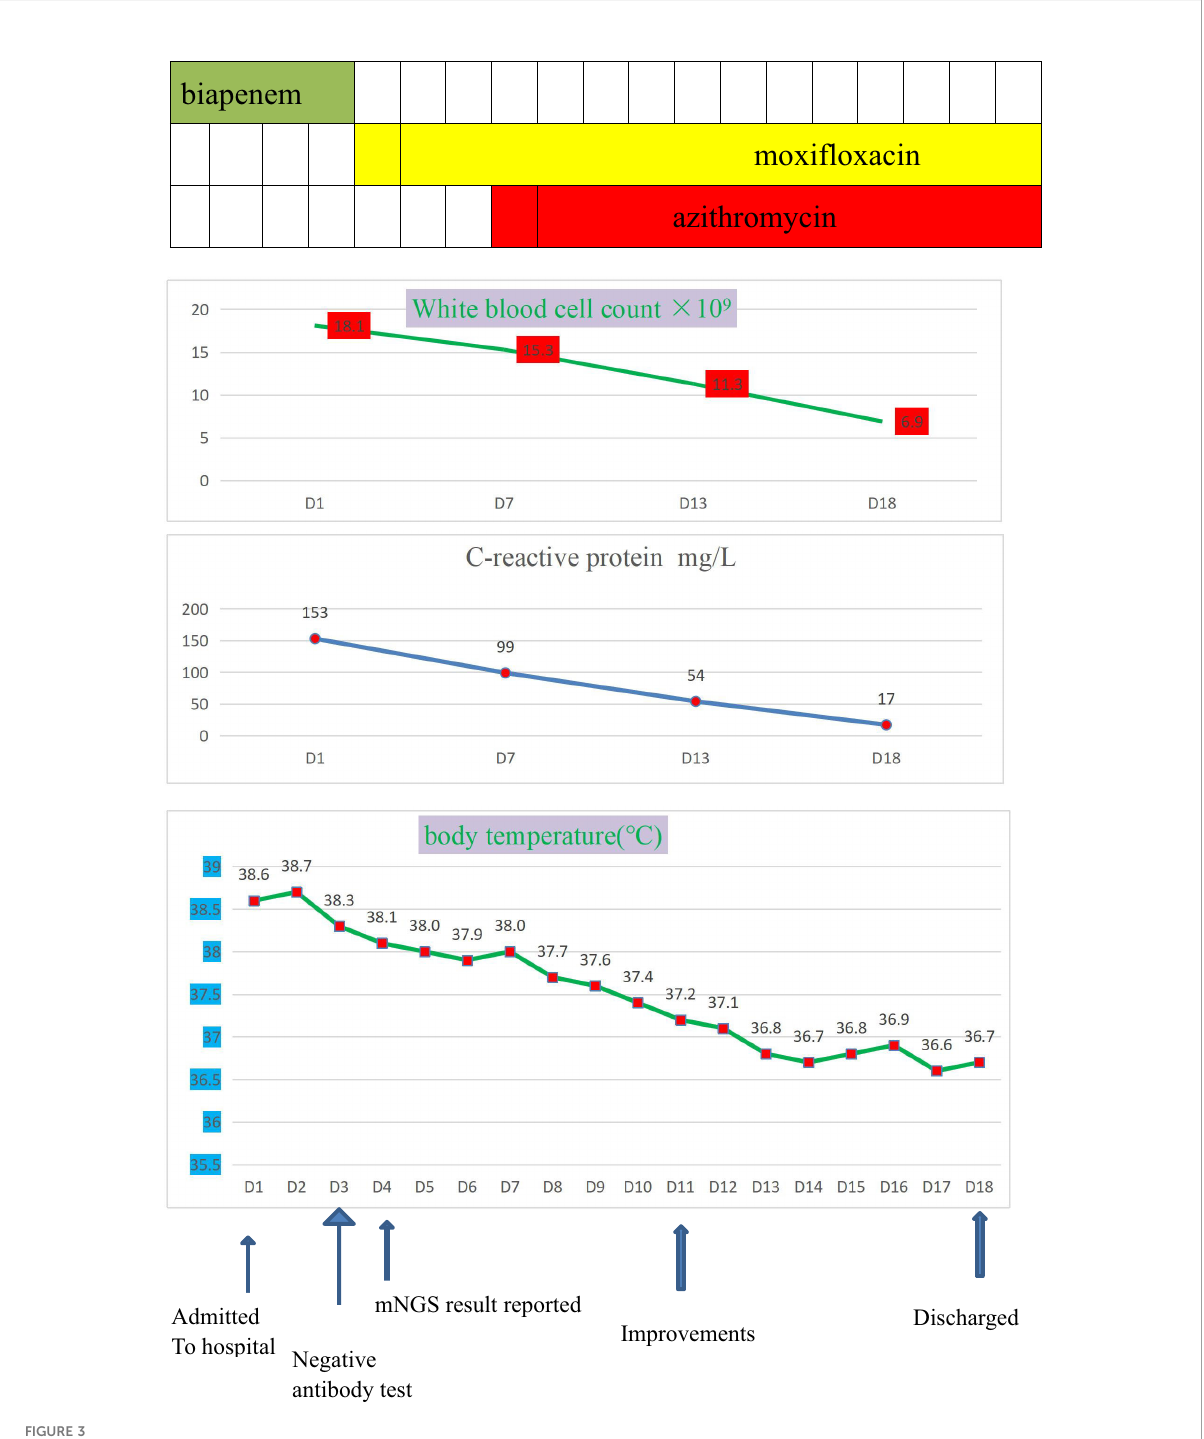
FIGURE 3 The clinical course of the patient with Legionella pneumophila infection.Drug therapies (top), blood indicators (middle), and body temperature (bottom) during